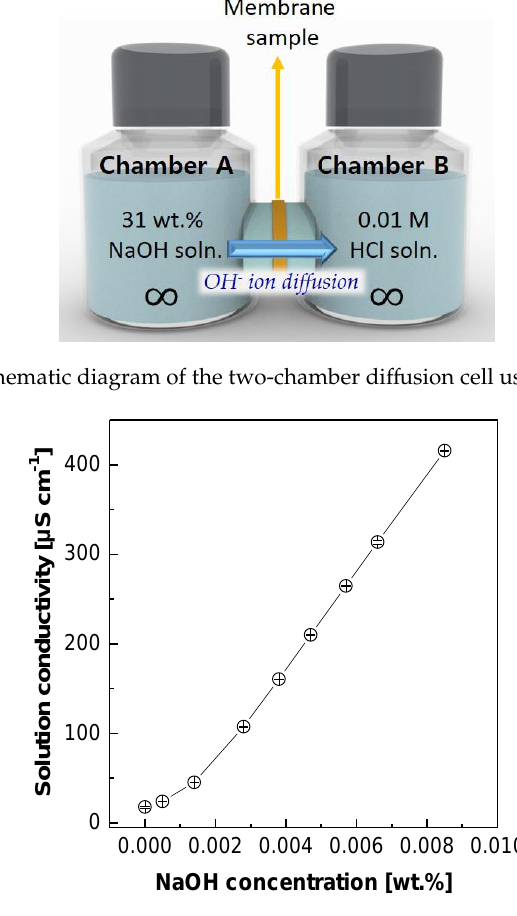
Figure 3. The correlation curve of NaOH solution conductivity with its concentration.